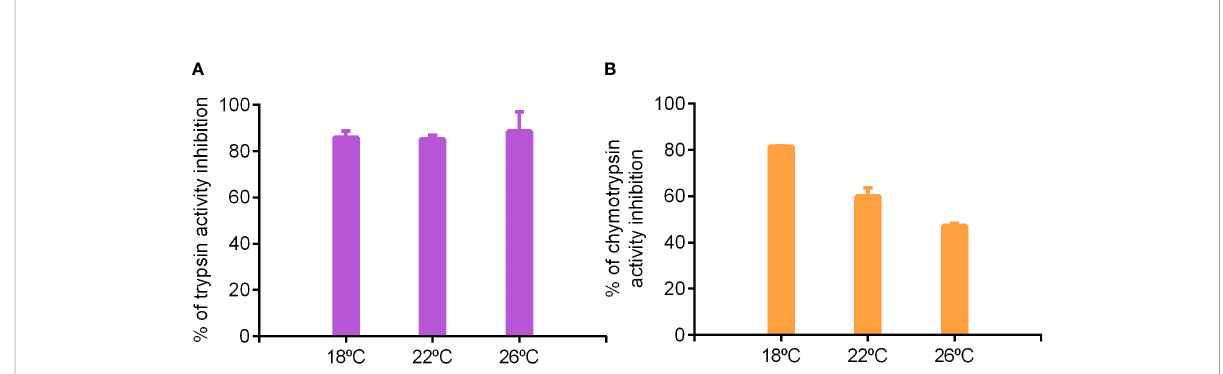
FIGURE 6 Effect of TLCK (A) and TPCK (B) inhibitors on trypsin and chymotrypsin activities, respectively, of pyloric caeca of S. dumerili adapted to different rearing temperatures (18, 22 and